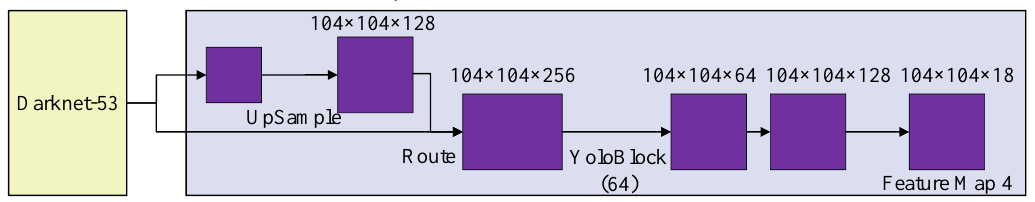
Figure 6. The fourth feature map for YOLO.